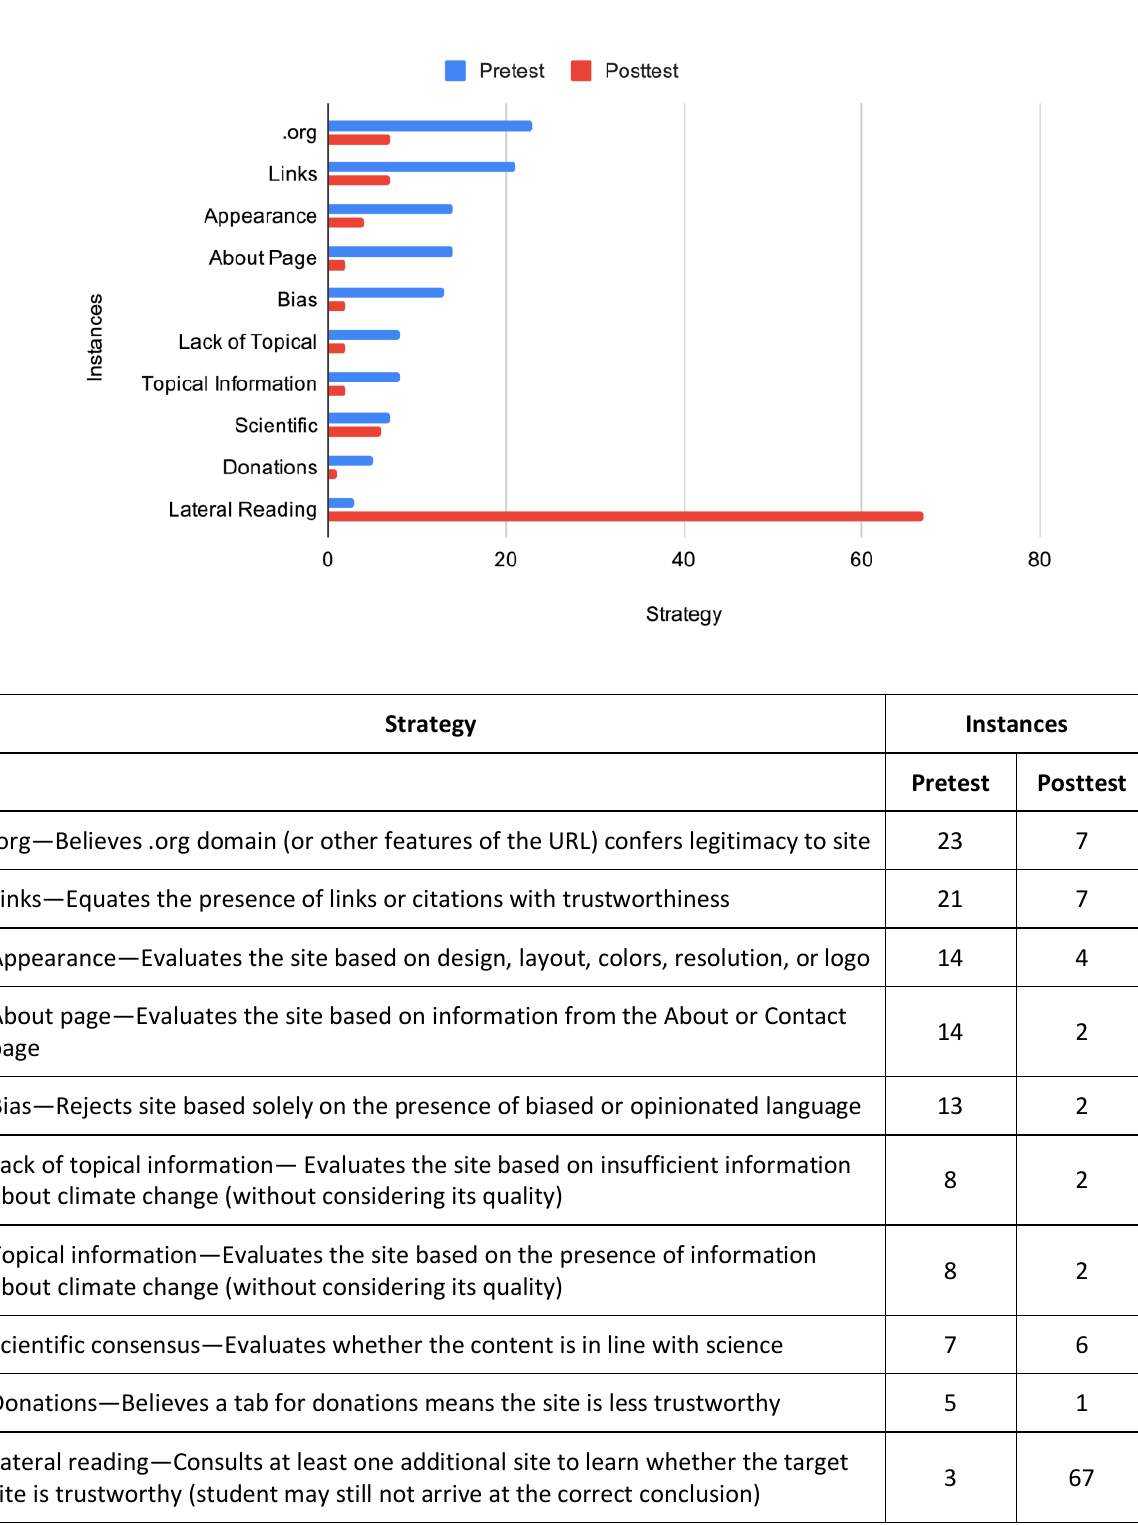
Figure 2. Evaluation strategies used before and after students completed